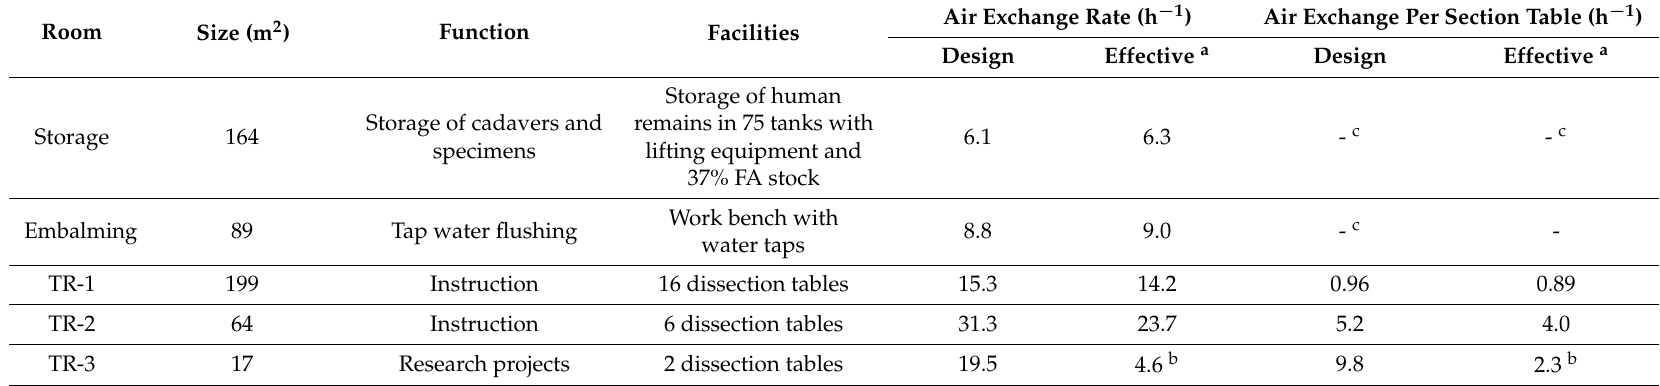
Table 1. Technical information on the rooms available in the anatomy research and teaching